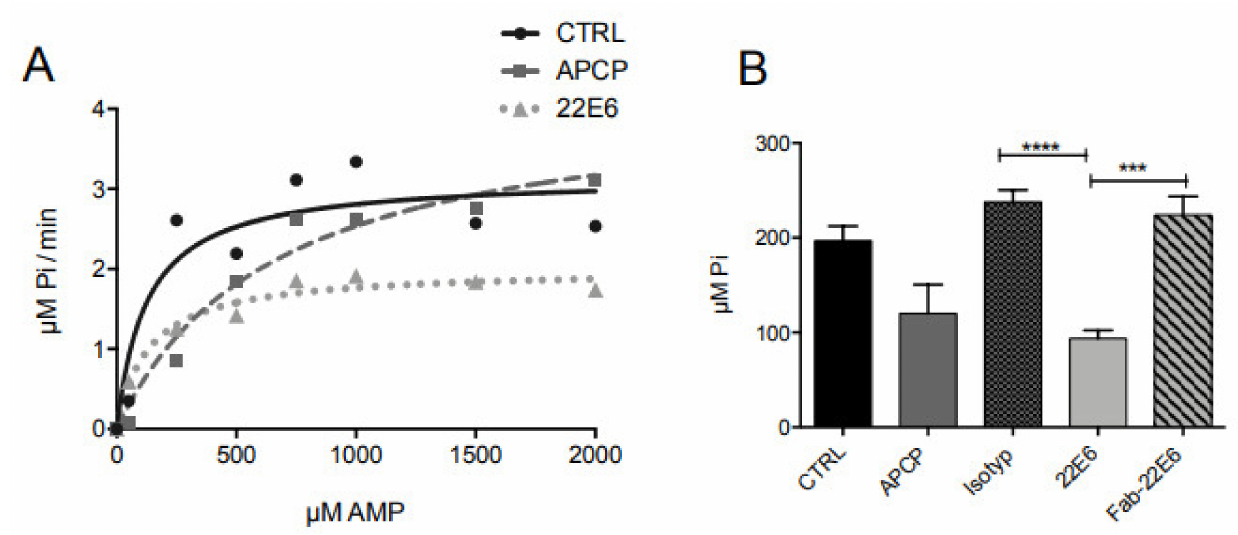
Figure 4. 22E6 is a non-competitive inhibitor of CD73. ( A ) Incubation of U138 MG cells with 22E6 and increasing concentrations of AMP resulted in a decreases Vmax. ( B ) The 22E6 antibody but not the 22E6 Fab fragments inhibits CD73 activity. One representative experiment of three is shown. *** p < 0.001; **** p <